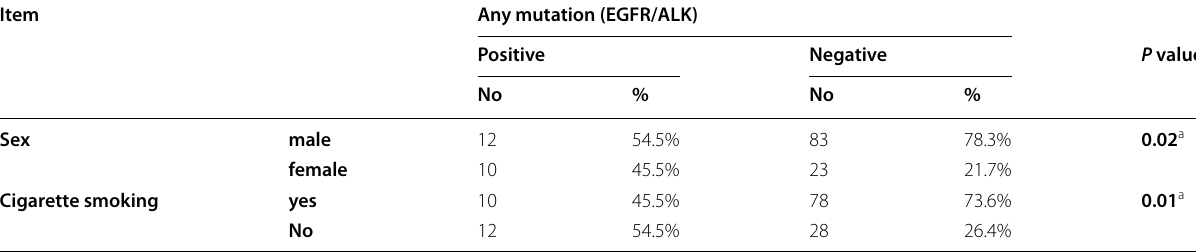
Table 3 Association between mutation status (EGFR and/or ALK) with gender and smoking